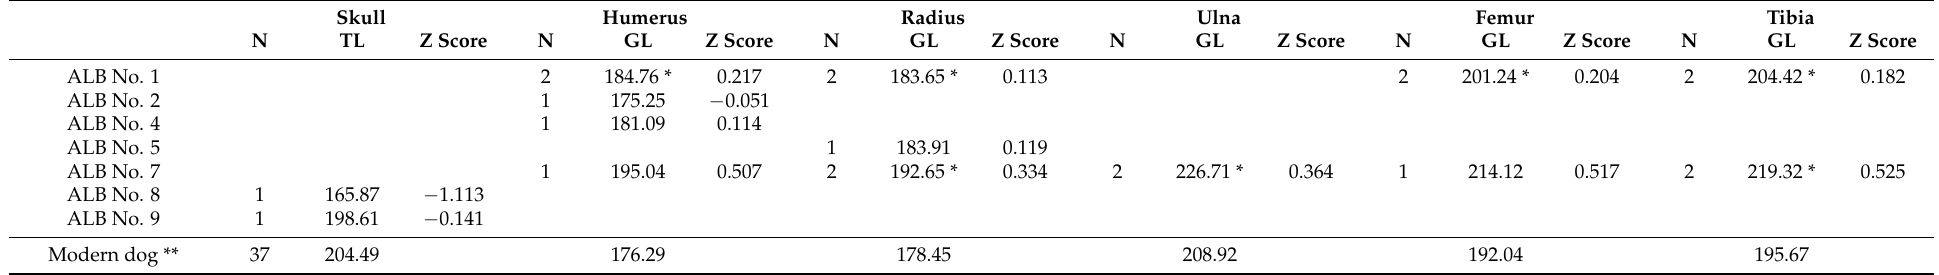
Table 6. Osteometric measurements of the Alaybeyi dogs and their comparison with average mean of modern dog